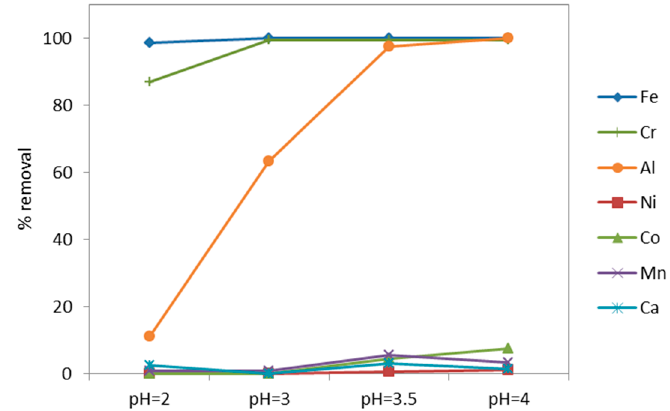
Figure 6. Effect of pH on metal removal during precipitation of trivalent metals from pregnant leach solution (PLS) obtained from one-step leaching test at 10% pulp density .